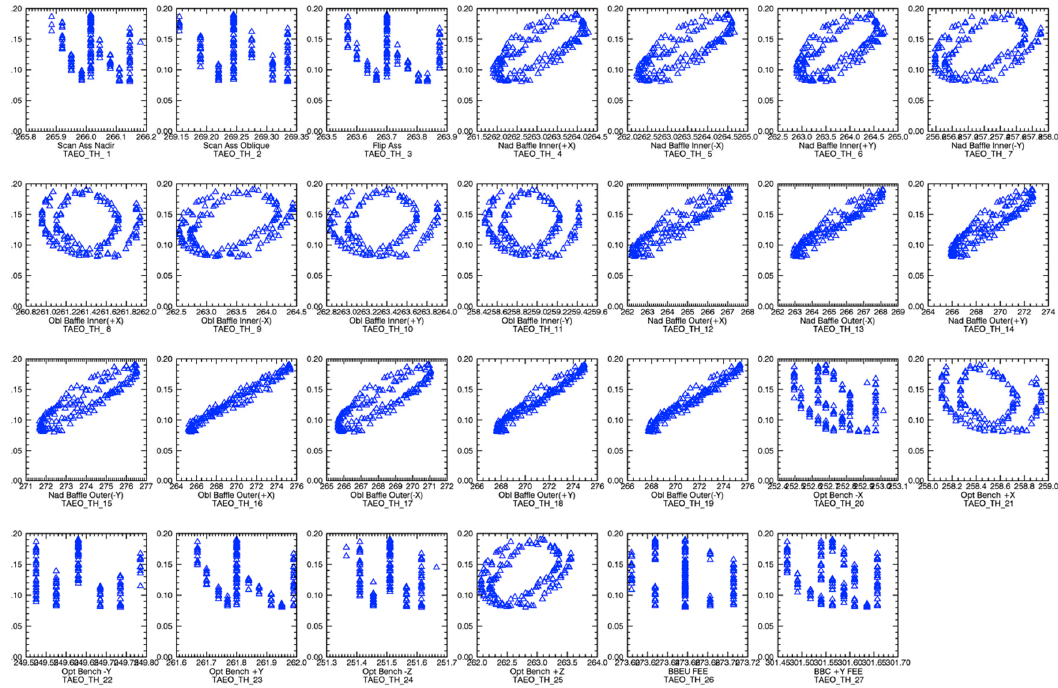
Figure 14. Correlations of SLSTR-A nadir view calibration temperature differences (vertical axes) against internal instrument temperatures from TAEO thermometers (horizontal axes) measured during the orbital simulation tests.